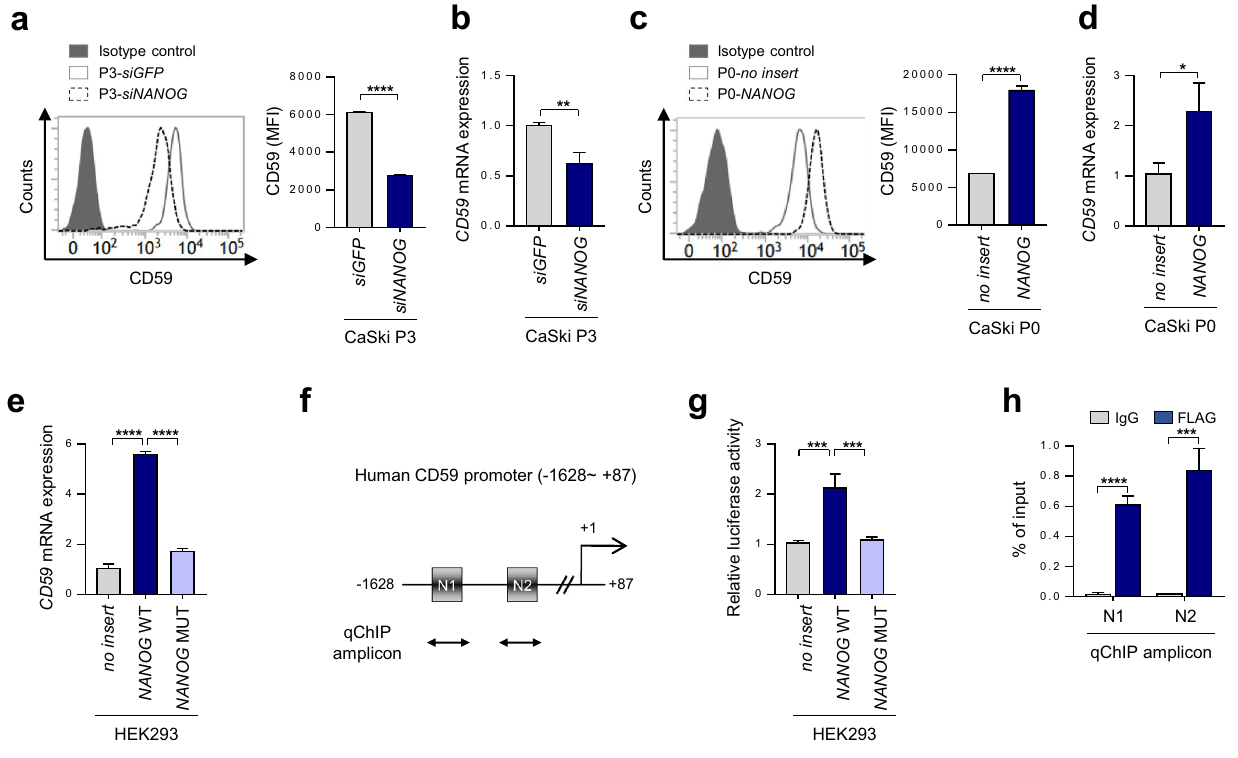
Figure 3. NANOG directly regulates CD59 expression through promoter occupancy. ( a , b ) CaSki-P3 cells were transfected with siRNAs targeting GFP or NANOG. ( c , d ) CaSki P0 cells were stably transfected with an empty vector (no insert) or NANOG. ( a , c ) Protein levels of CD59 were determined by flow cytometry analysis. Data are presented as the mean fluorescence intensity (MFI). ( b , d ) The mRNA expression of CD59 was analyzed by real-time quantitative RT-PCR. ( e ) HEK293 cells were transfected with an empty vector (no insert), NANOG wild-type (WT), or NANOG mutant (MUT). The mRNA expression of CD59 in the transfected cells was analyzed by real-time quantitative RT-PCR. ( f ) Diagram of the CD59 promoter region (-1628 to + 87) that contains two NANOG binding elements, indicated by N1 and N2, respectively. Arrows indicate qChIP amplicon corresponding to N1 and N2. ( g ) Luciferase assay in HEK293 cells transfected with the pGL3-CD59 plasmid, together no insert, NANOG WT or NANOG MUT plasmids. A vector expressing β-galactosidase was co-transfected to ensure the transfection efficiency and normalize the luciferase activity values. For analysis of the promoter activity, luciferase activity was normalized to control cells, transfected with no insert plasmid. ( h ) The cross-linked chromatin from HEK 293 cells transfected with FLAG-NANOG was immunoprecipitated with mouse IgG or anti-FLAG antibodies. Relative enrichment of FLAG-NANOG on the CD59 promoter region was assessed by qChIP-PCR analysis with primers that amplify the genomic region indicated by N1 and N2, respectively. The value of ChIP data represents relative ratio to the input. All experiments were performed in triplicate, and error bars represent standard deviations from the mean. Differences in experimental values were statistically tested using the Student’s t-test ( a – d ) , two-way ANOVA ( h ) or one-way ANOVA ( e , g ): * p < 0.05; ** p < 0.01, *** p < 0.001, **** p <